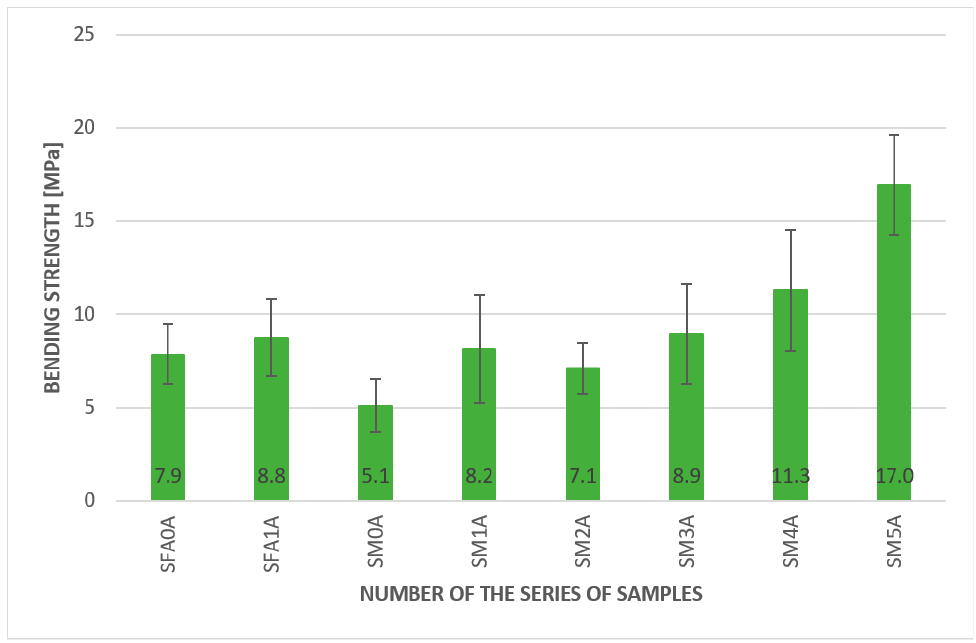
Figure 6. Results of the bending strength test for geopolymer composites at ambient temperature.